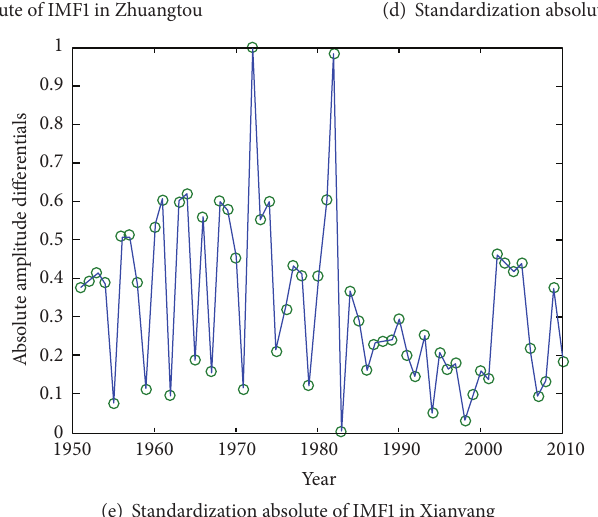
Figure 3: Standardization absolute of IMF1 at each hydrological